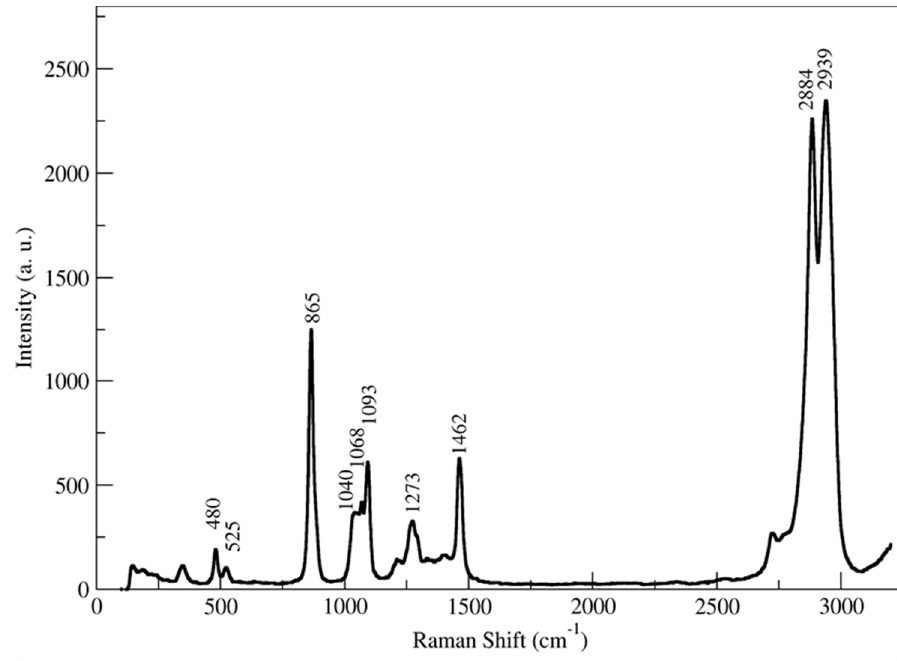
Figure 9. Raman spectrum of liquid ethylene glycol acquired at room temperature (22 °C).